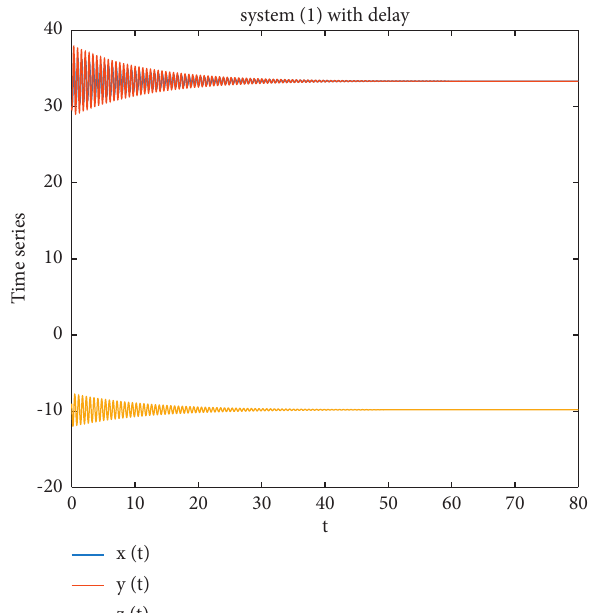
Figure 2: For system (1) with parameter values ( a,b, c,k, k τ � 0 . 16, the equilibrium E